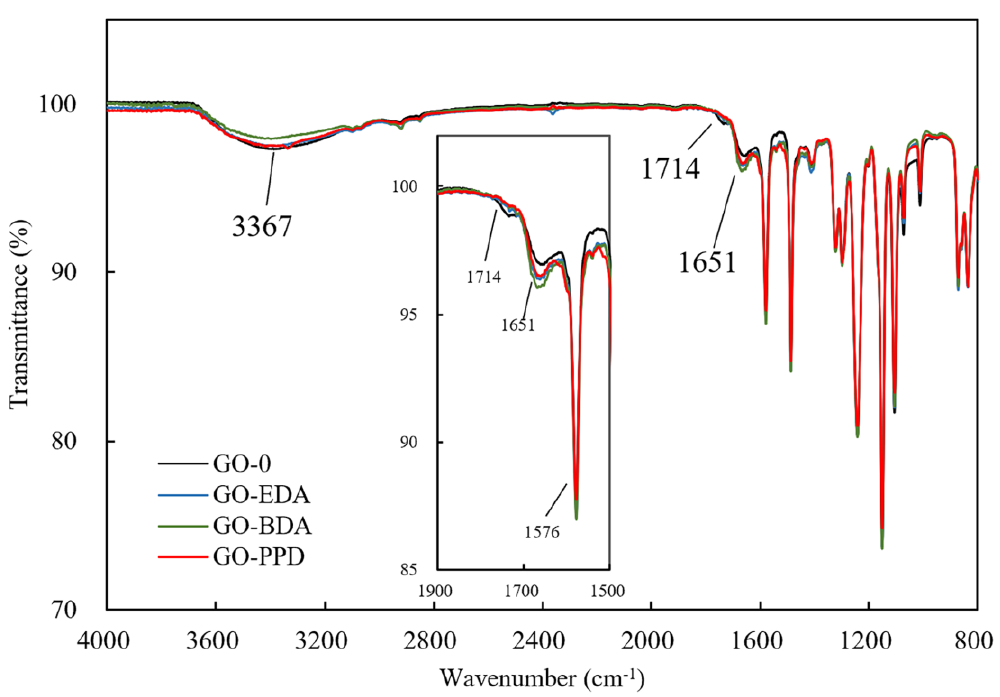
Figure 3. Infrared spectrogram of cross-linked GO membrane.